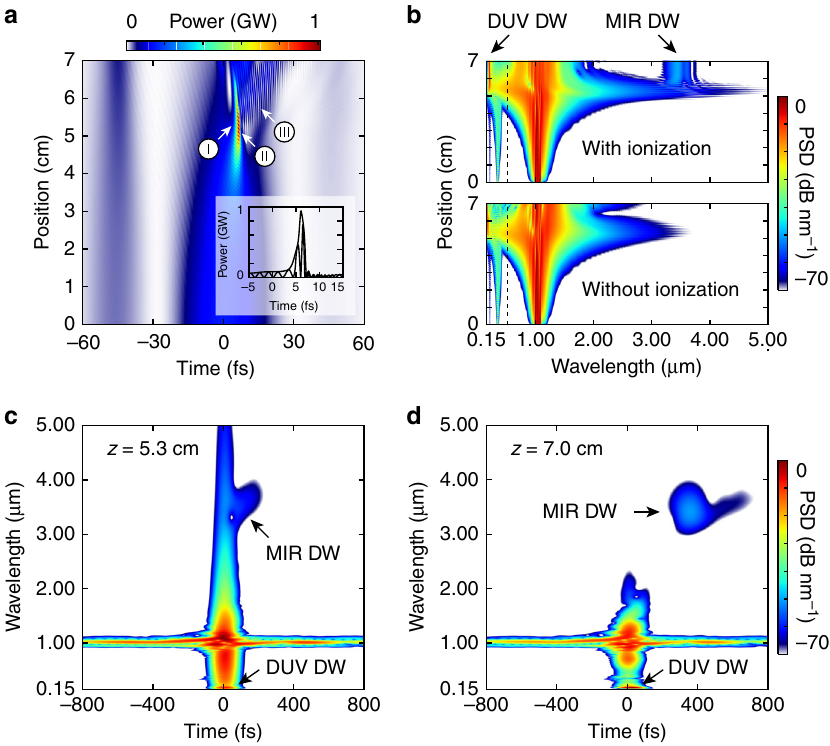
Fig. 3 Numerically simulated pulse propagation and time-frequency analysis. Fibre fi lled with 4 bar of argon, 6 μ J input pulses (measured using frequency- resolved optical gating). a Evolution of the temporal pulse shape with propagation distance. The inset shows the pulse at the maximum temporal compression point. (I) — maximum temporal compression point. (II) — shock front. (III) — deep ultraviolet dispersive wave (DUV DW). The pedestal is caused by nonlinear compression of the initially ~300-fs-long pulses from the pump laser ( “ Methods ” section). It is also visible in c , d . b Evolution of the power spectral density (PSD, normalized to the peak of the spectrum) with propagation distance, when ionization is included and when it is switched off (the corresponding evolution of the temporal pulse shape is shown in Supplementary Note 4). The dispersion is anomalous on the long-wavelength side of the zero dispersion point (dashed line). Mid-infrared (MIR) DW emission disappears when ionization is switched off. c Spectrogram of the pulse at 5.3 cm (maximum temporal compression point), calculated using a 50-fs-long Gaussian gate pulse. d Spectrogram of the pulse at 7 cm ( fi bre